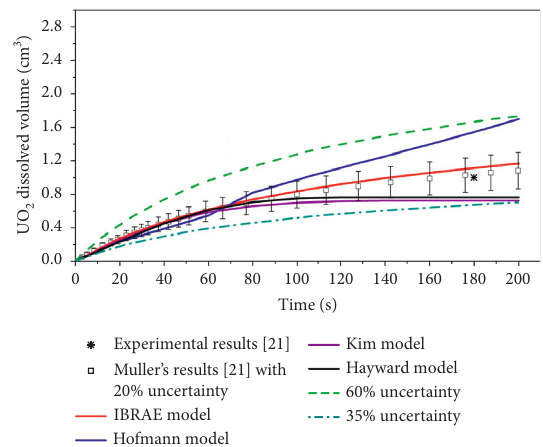
Figure 9: Comparison of dissolved UO models at 2200 °